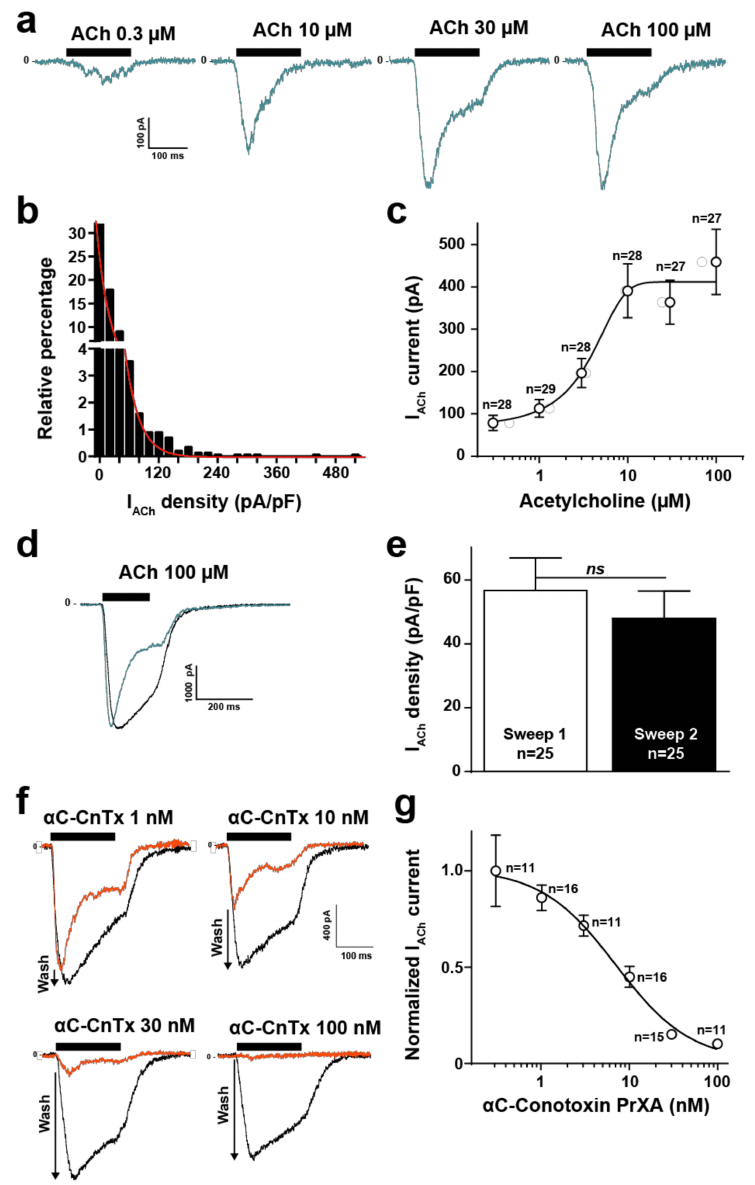
Figure 1. ACh and α C-conotoxin PrXA effects on TE671 cells. ( a ) Representative ACh-mediated currents at increasing ACh